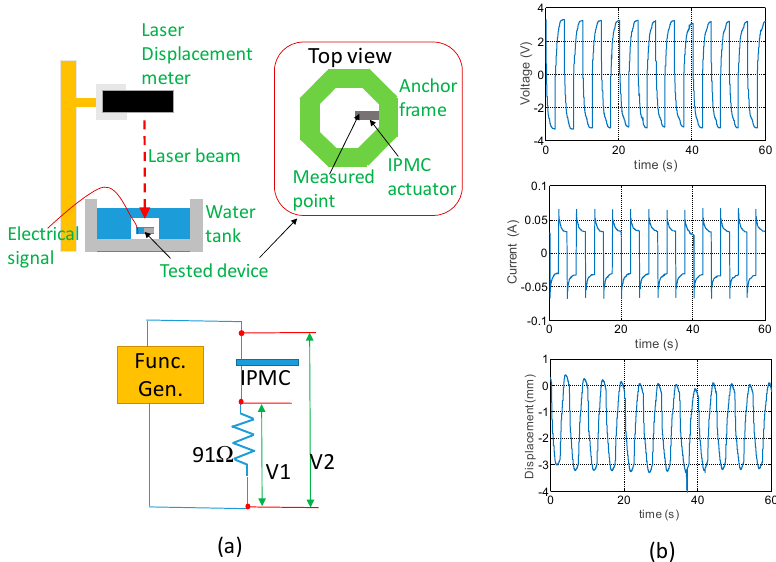
Figure 9. ( a ) Experimental setup for testing a single IPMC actuator performance in water. ( b ) Measured results of voltage drop across, current flowing through and displacement of the IPMC actuator.